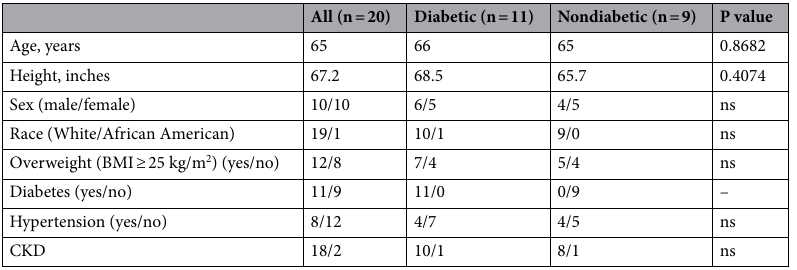
Table 1. Patient characteristics. Values are means or n. Categorical data were analyzed by using Fisher’s exact test (ns denotes P > 0.05). BMI body mass index, CKD chronic kidney disease.